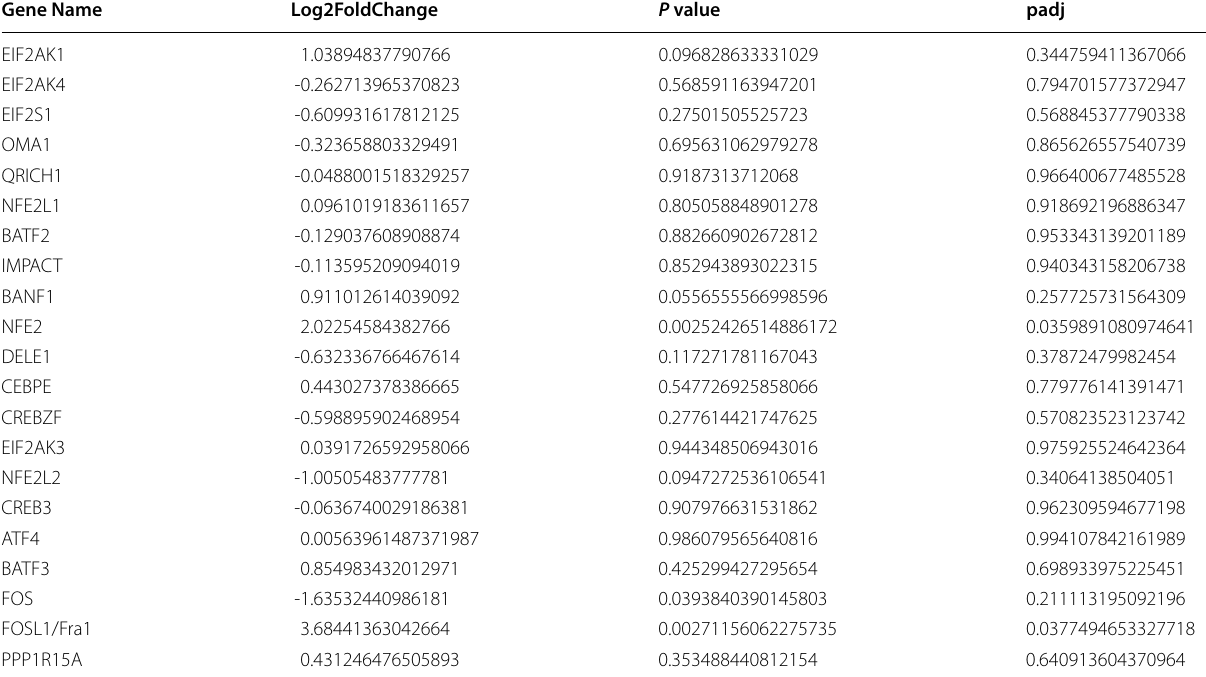
Table 4 Differentially gene expression in ISR-related gene (according to Gene Ontology) in probands in Family 1 and nonfamilial